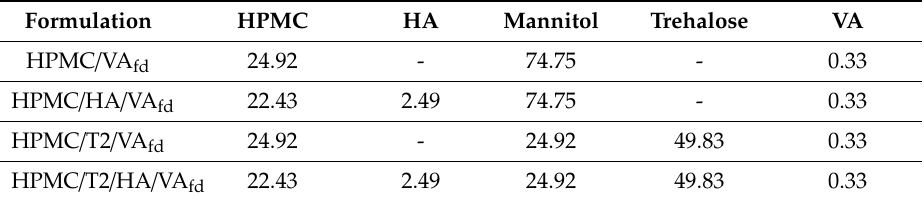
Table 1. Composition (wt %) of the polymeric vancomycin hydrochloride (VA)-loaded matrices used in this study. Formulation